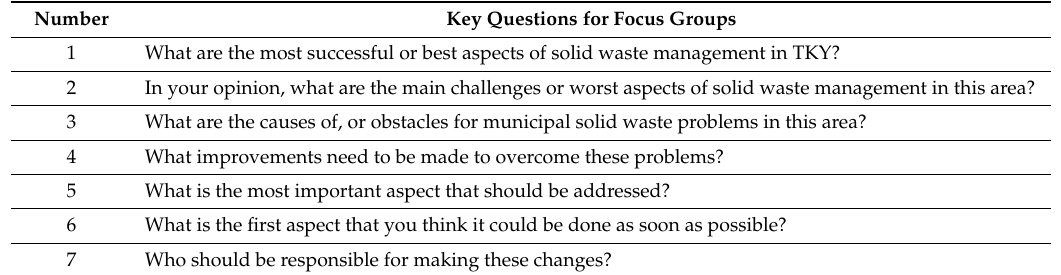
Table 3. Key questions for focus